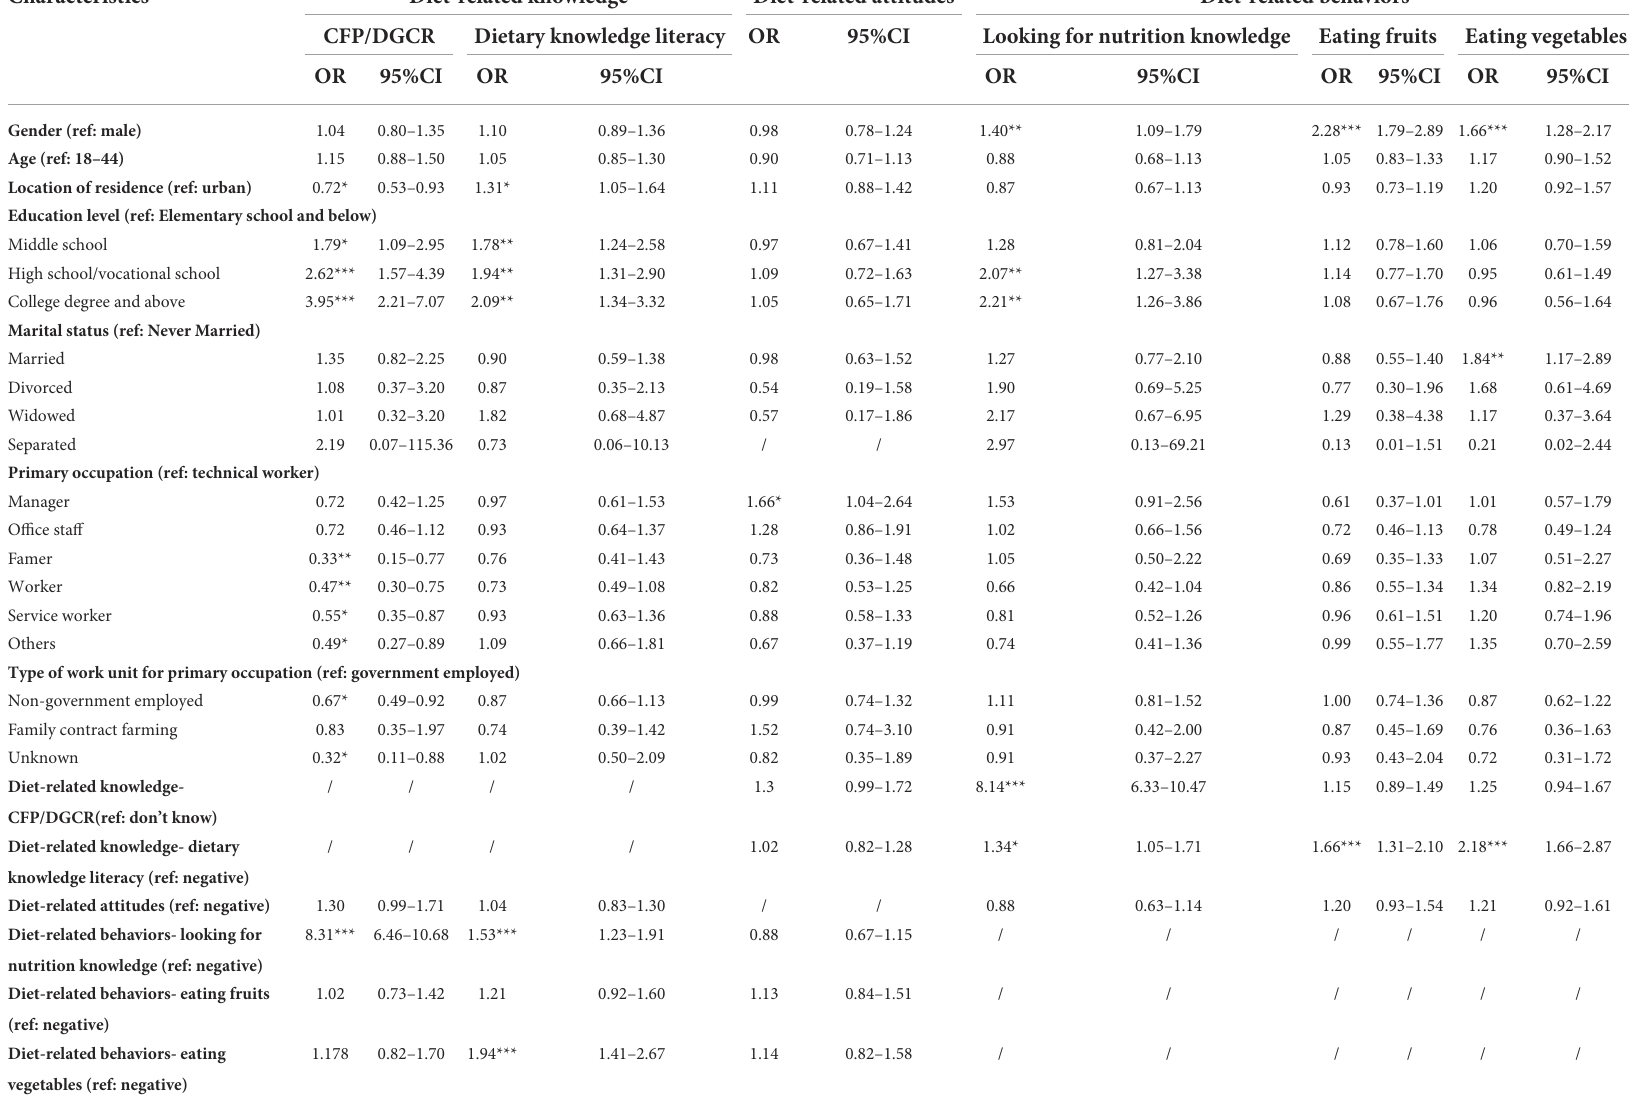
TABLE 2 Binary logistic regression analysis for the characteristics associated with diet-related knowledge, attitudes, and